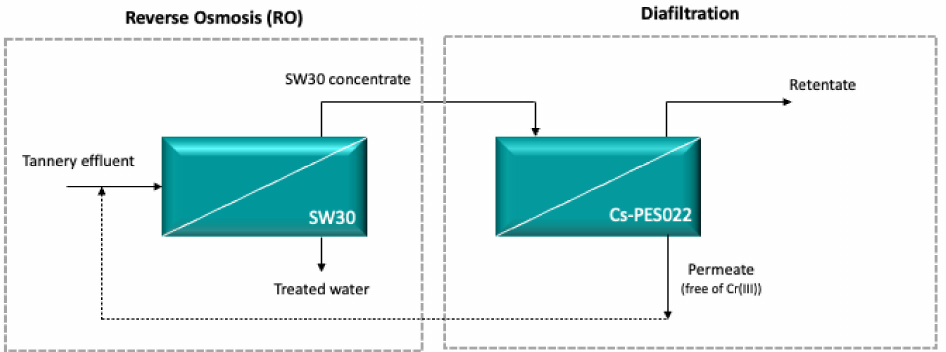
Scheme 2. Schematic representation of the integrated RO-diafiltration process for purification of a real tannery effluent from TAMEG-Rouiba-SPA and selective recovery of